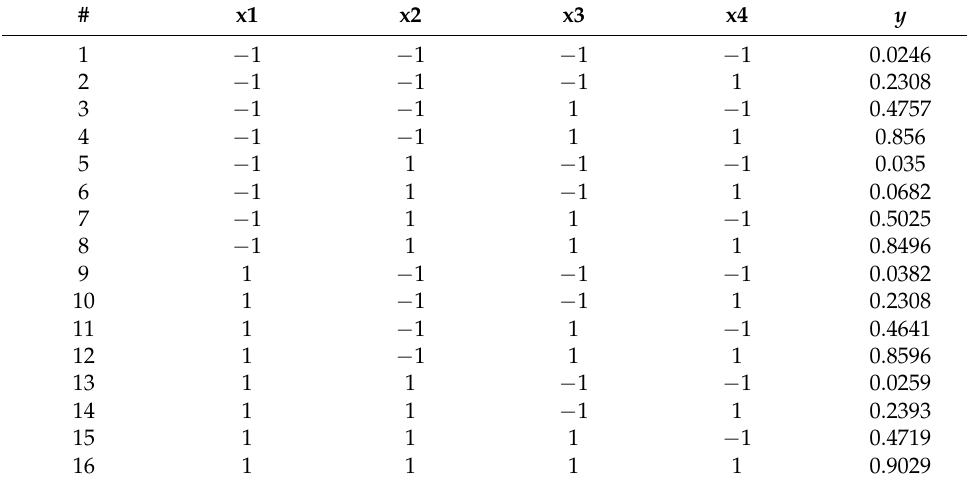
Table 3. Variation of Xi vs. result of variable y